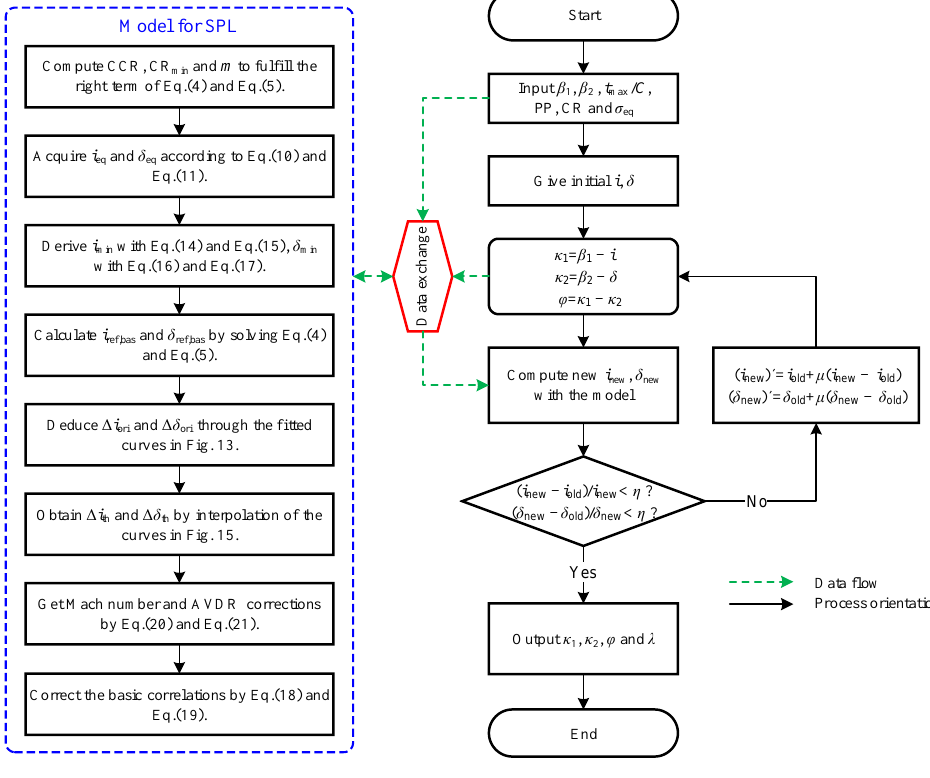
Figure 18. Calculation steps of the correlation model.